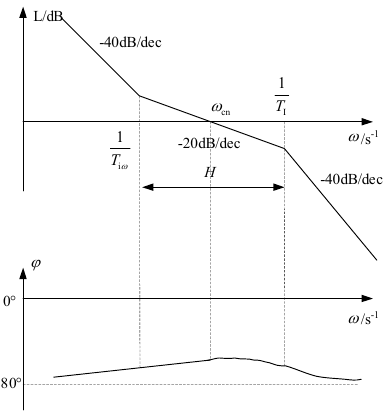
Figure 11. Open-loop Bode diagram of rotational speed.